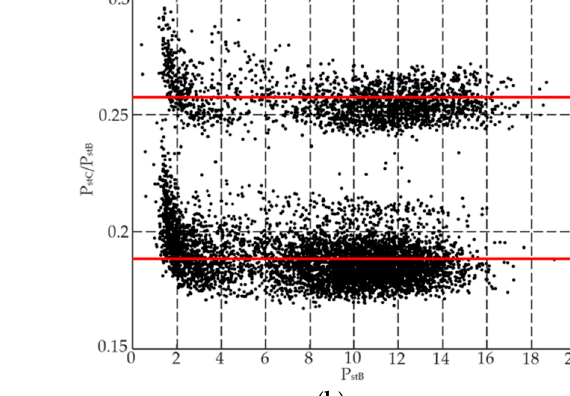
( d ) Figure 10. Histograms of two furnace conditions ( a , b ) and graphs of differences in distribution functions of the measured values P st and determined distributions ( c , d ).